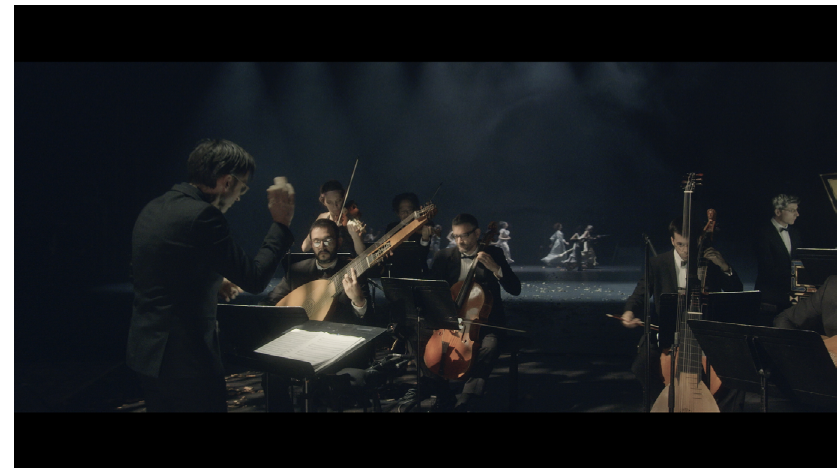
Fig. 3 – Marc-Antoine Charpentier, Actéon , directed by Benjamin Lazar, still photo. © Camera Lucida